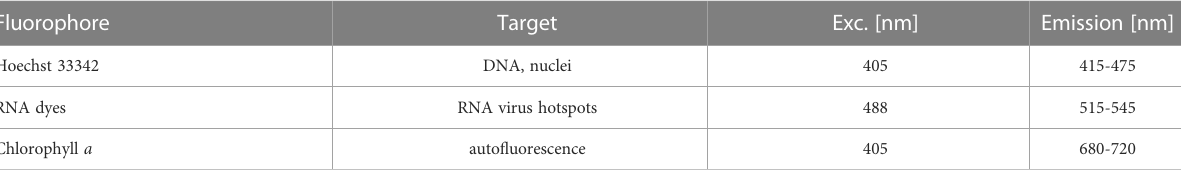
TABLE 1 Fluorochromes speci fi